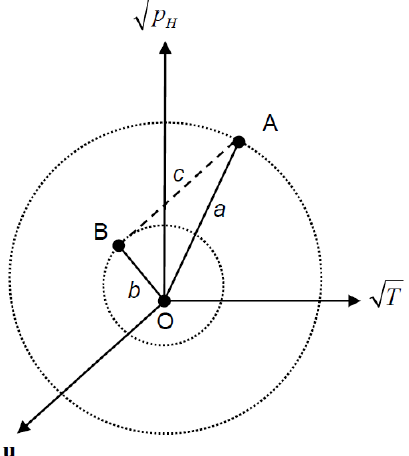
Figure 9. Multi-variate phase space for a hydrostatic flow in pres- sure coordinate. For ease of visualization, wind u is shown as a 1-D axis instead of a 2-D plane and each axis represents one among an √ p H ) or infinite number of degrees of freedom on the surface (for √ T and u ) of a fluid. The length of phase vectors in the volume (for A and B are a and b respectively while their separation is c in this subspace. O is the null vector. The spheres represent hyper-surfaces of constant